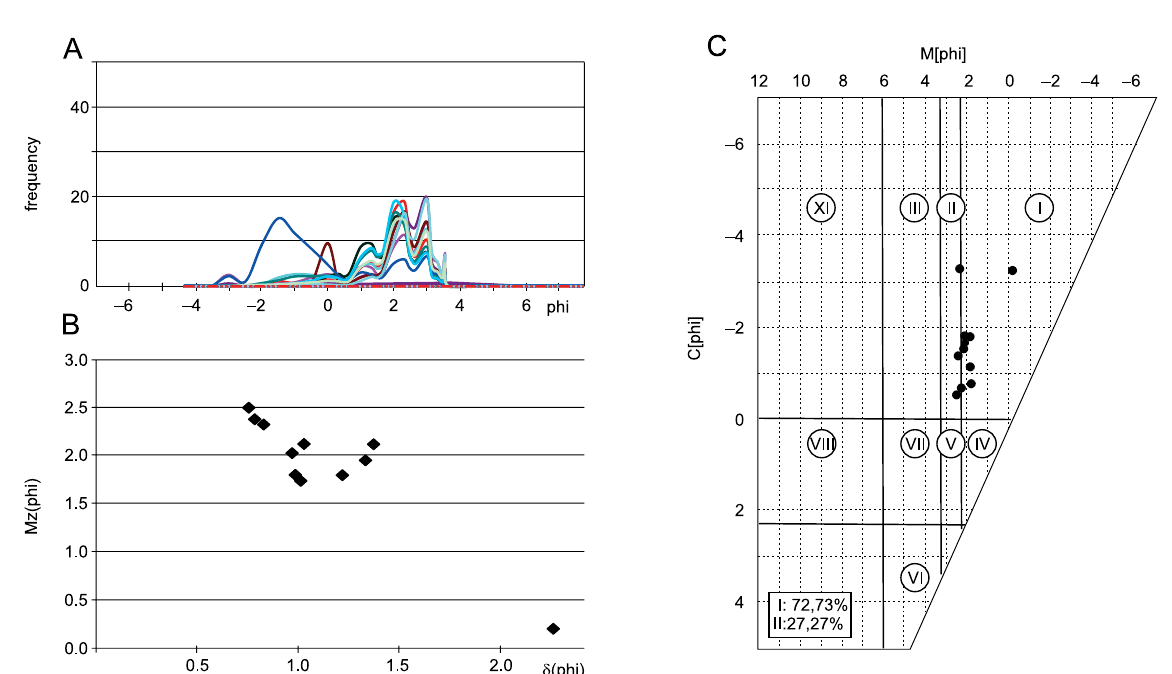
Fig. 5. a. Frequency curves of sediments in the Piaski Pomorskie test stand, B. comparison of granulation indices mz-δ for samples of sediments in the Piaski Pomorskie stand, c. Passega diagram for sediments in the Piaski Pomorskie test